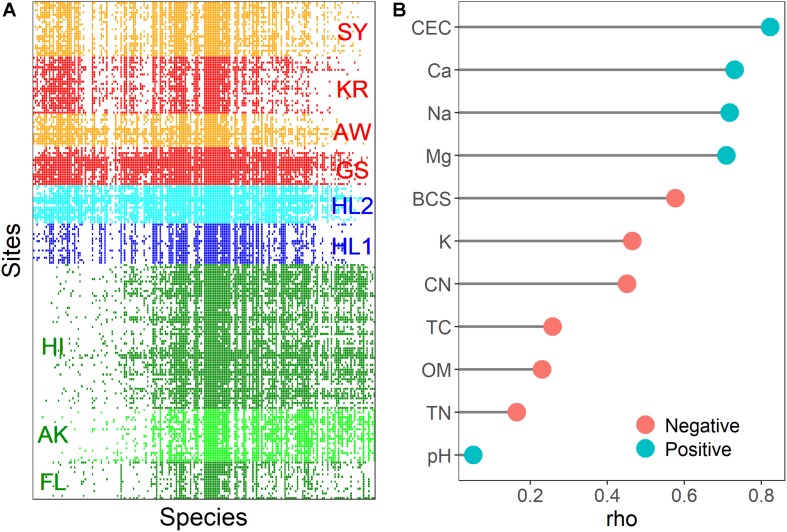
A visualization of the meta-community analysis with sites as rows and OTUs as columns (A). The colored rectangles (red: Gotjawal, blue: Jeju, green: Others) indicate a OTUs occurrence at a site. Spearman coefficients (rho value) of the soil physicochemical properties associated with the structuring gradient species distribution (B). The red and blue colors of the circle indicate negative and positive correlation between soil properties and site scores, respectively.